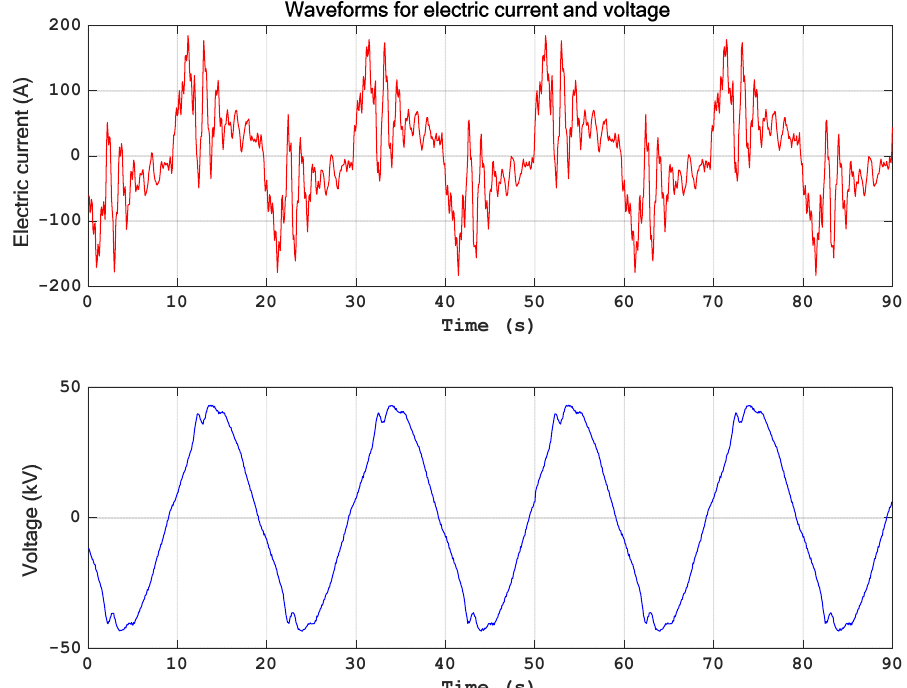
Figure 2. The time variation of the current and voltage in the power supply station.